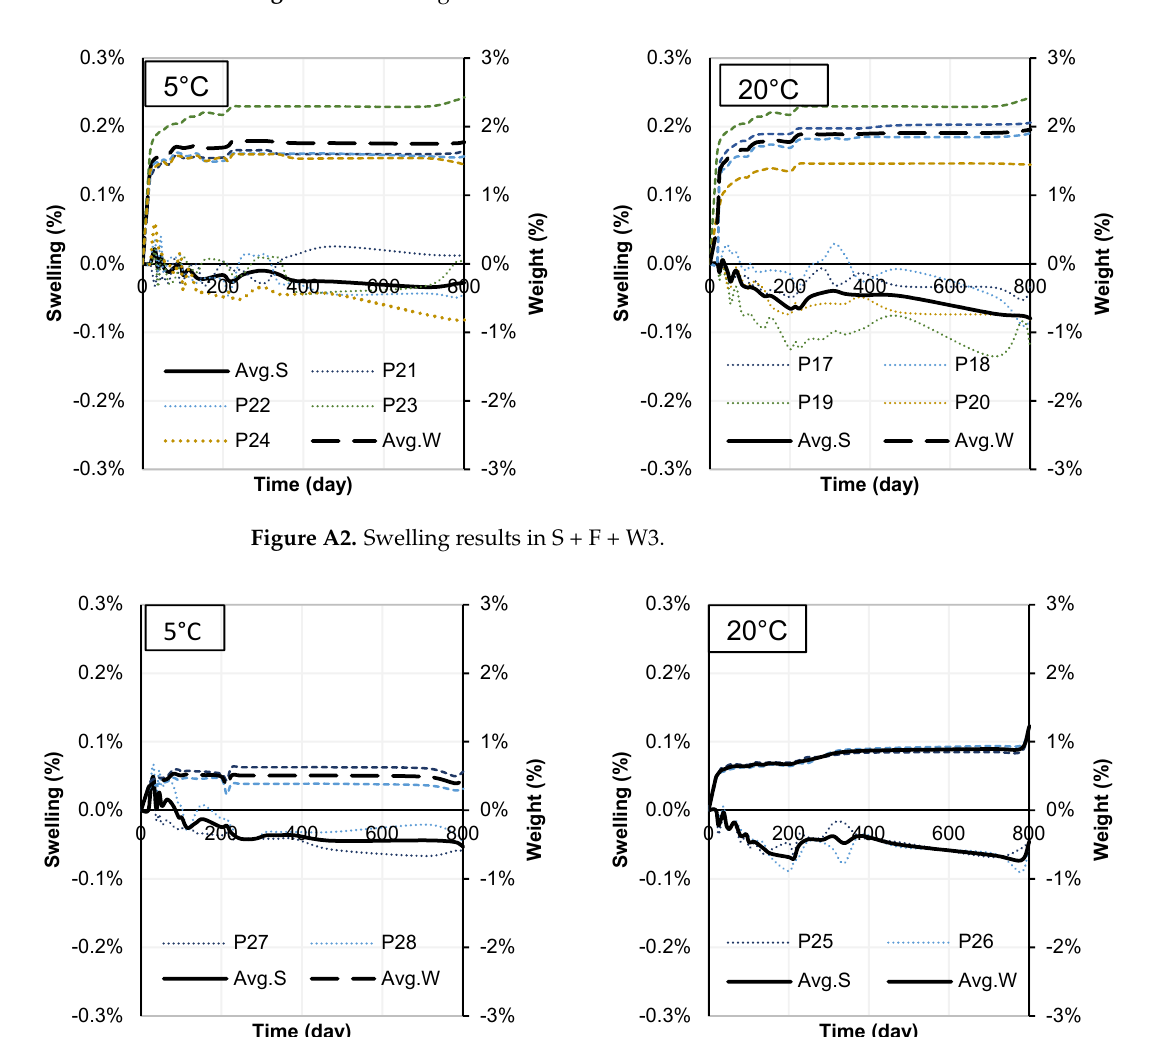
Figure A3. Swelling results in S + C + W1.